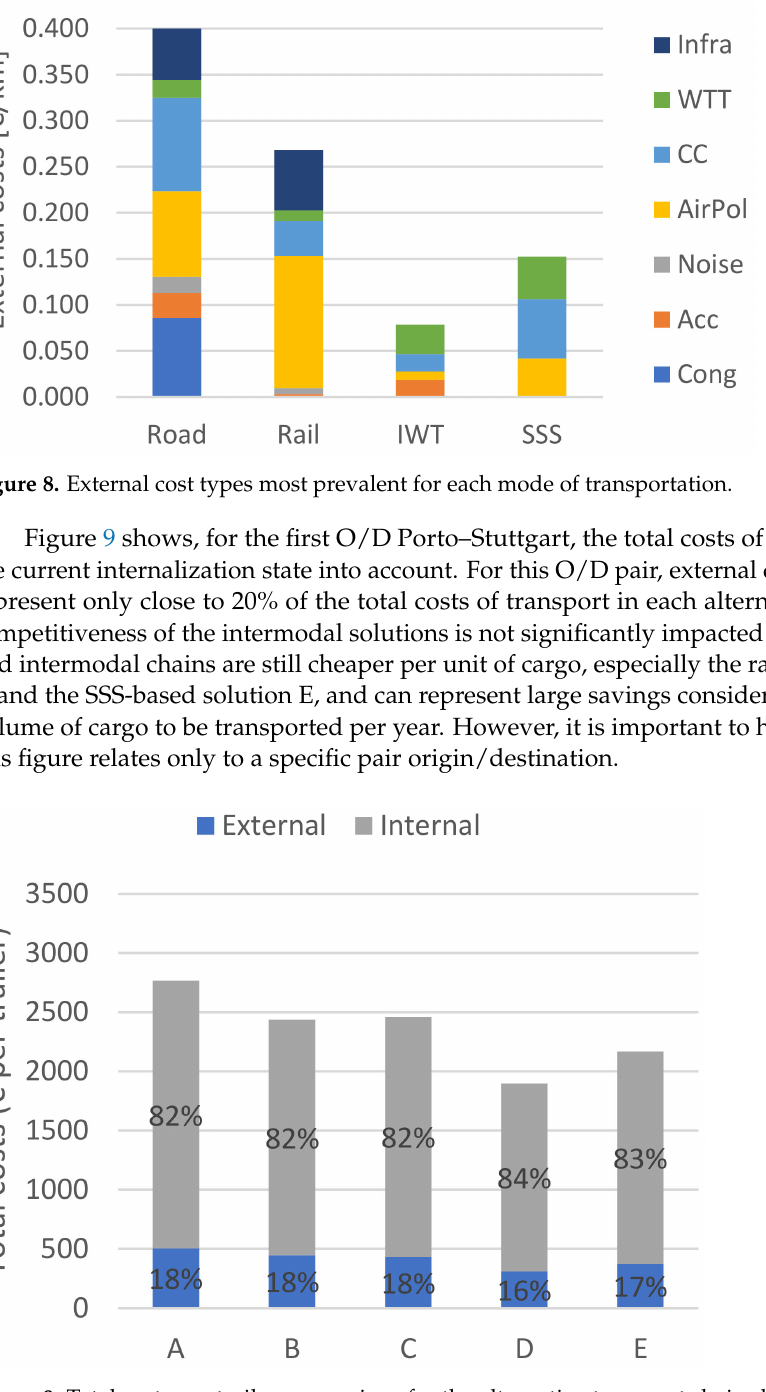
Figure 9. Total costs per trailer comparison for the alternative transport chains between Porto and Stuttgart, taking the current internalization state into